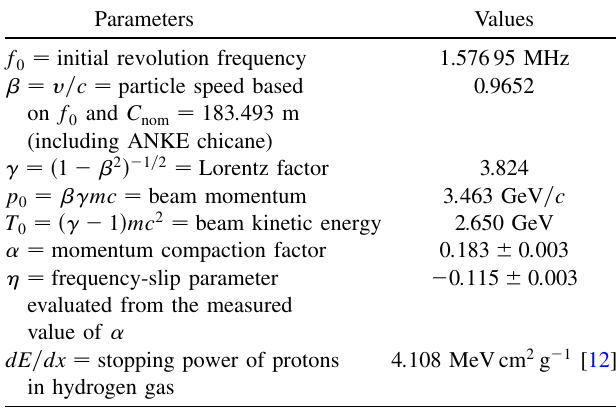
TABLE I. Parameters relevant for the target thickness evalu- ation at 2.650 GeV.